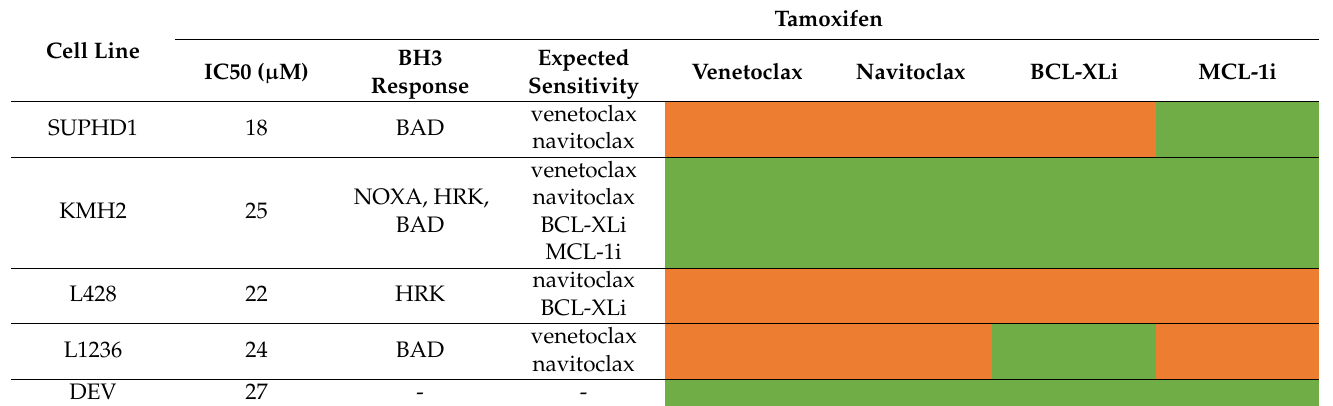
Table 4. Overview of the effect of tamoxifen on HL cell